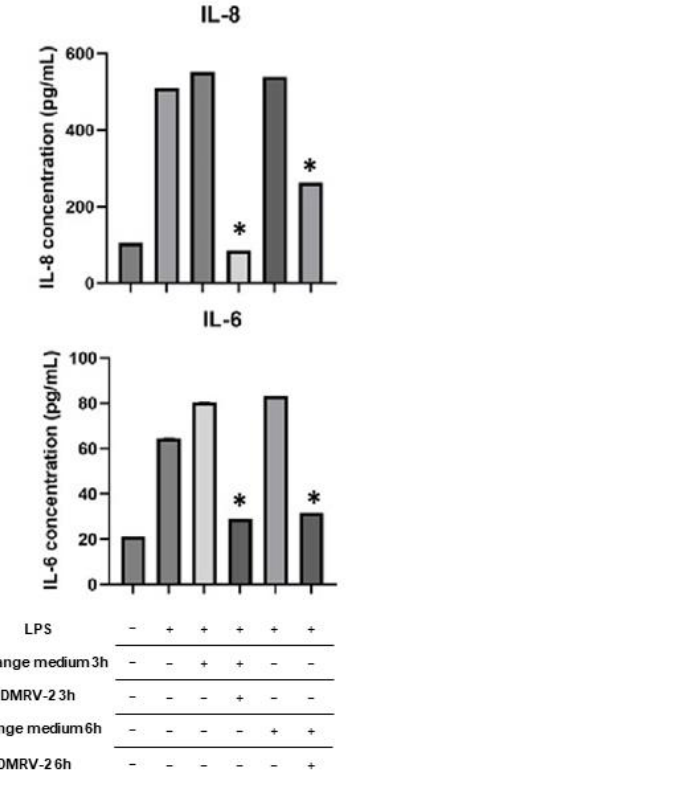
Figure 4. Analysis of IL-6 and IL-8 secretion in HUVECs. HUVECs were stimulated with 0.1 µg/mL LPS for 4 h and then incubated with DMVR-2 or underwent change of the medium. ELISA were performed to measure the concentration of IL-6 and IL-8 released after LPS stimulation, and after 3 h or 6 h of the different incubations. * p < 0.05 vs. respective controls.